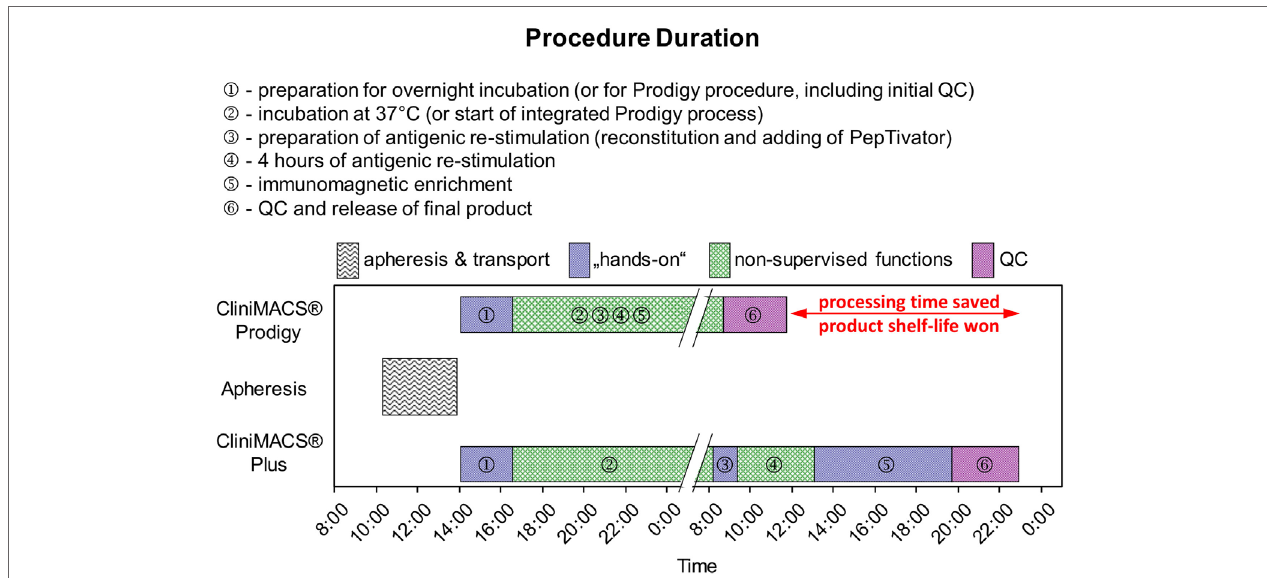
FIGURe 1 | schematic comparison of manufacturing processes for CMV-specific t-cells using CliniMACs ® Plus and CliniMACs Prodigy ® . Both processes are largely comparable for washing, incubation, and centrifugation steps during CCS procedures and the immunomagnetic enrichment of IFN- γ -secreting leukocytes. However, the processes via Plus procedure required additional labor steps resulted in a time delay to the next morning. Thus, the Prodigy process performance revealed a limited hands-on time period after the process